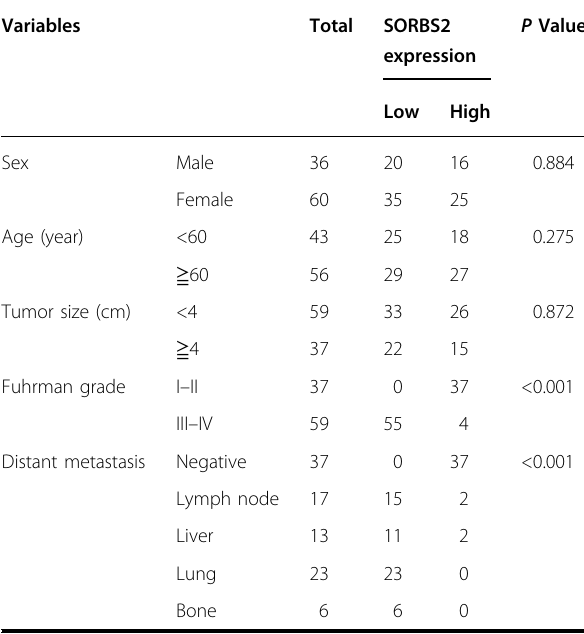
Table 1 Clinicopathological features of patients with